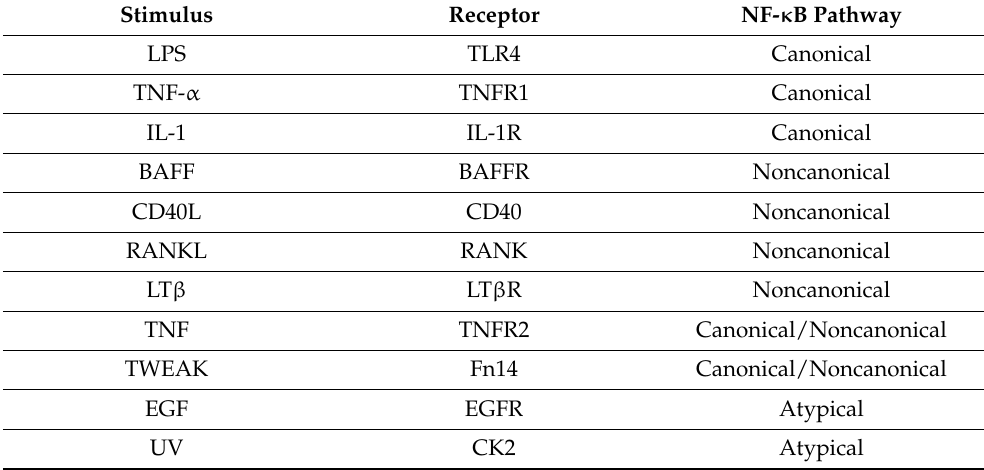
Table 1. Stimuli and receptors triggering NF- κ B activation